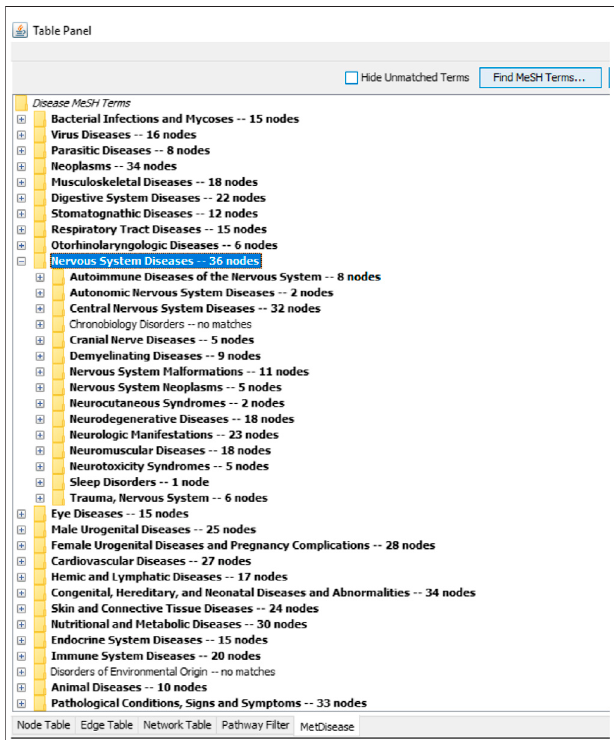
FIGURE 6 | The compatibility of the 31 biomarkers with nervous system diseases wasrecordedto bethe highest by36 nodes via asuccessfullinkage in